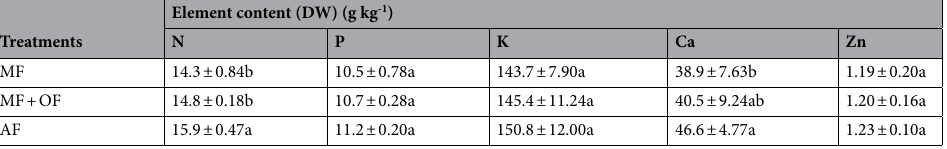
Table 1. Effects of different fertilizer treatments on nutritive element contents of kiwifruit. The different letters after the values indicated the significant differences (P < 0.05) of kiwifruit nutritive element contents between the treatments. The standard errors (n = 3) are presented.